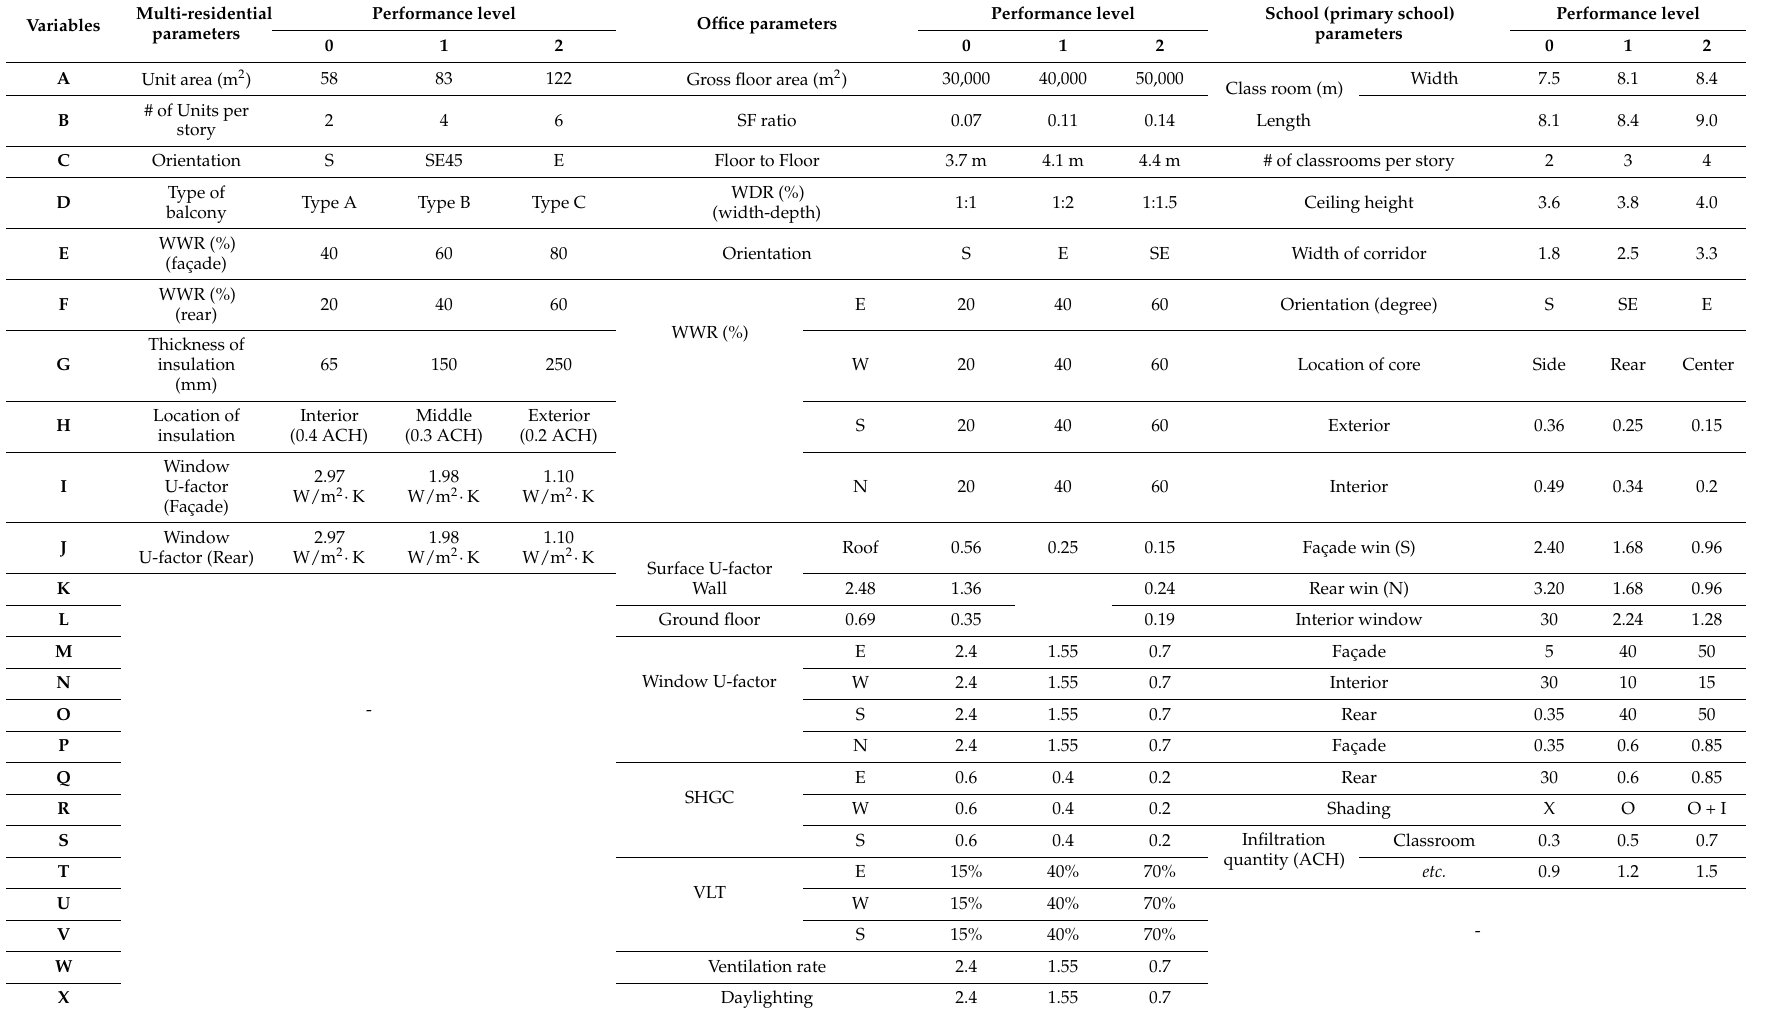
Table 2. Performance levels of the parameters for orthogonal